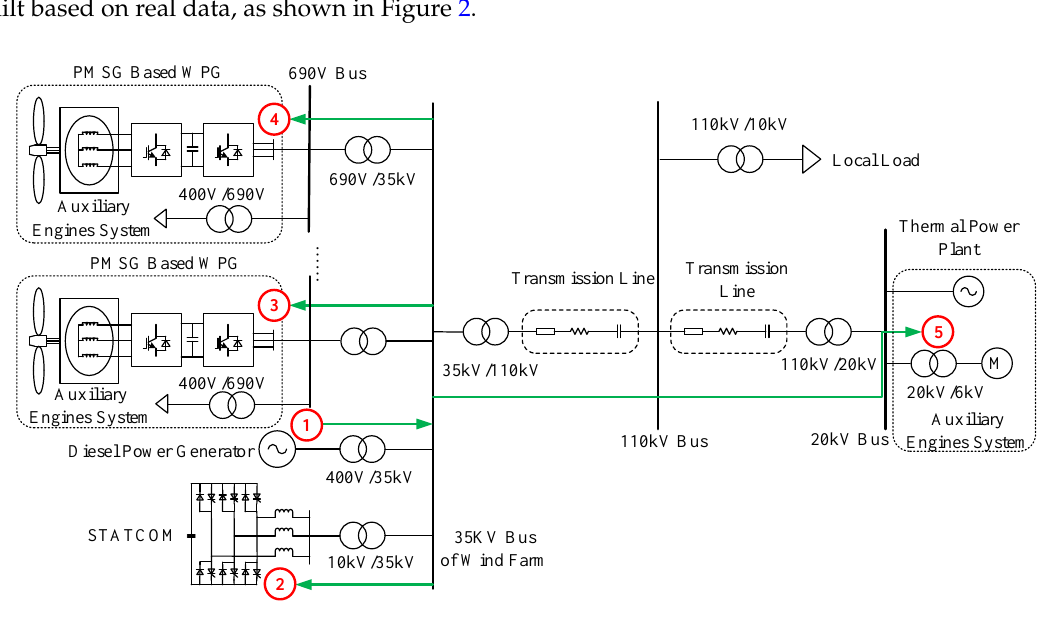
Figure 2. Structure of the local power system with a wind farm and thermal power plant (the red numbers with green lines represent the startup sequence in the black start procedure).